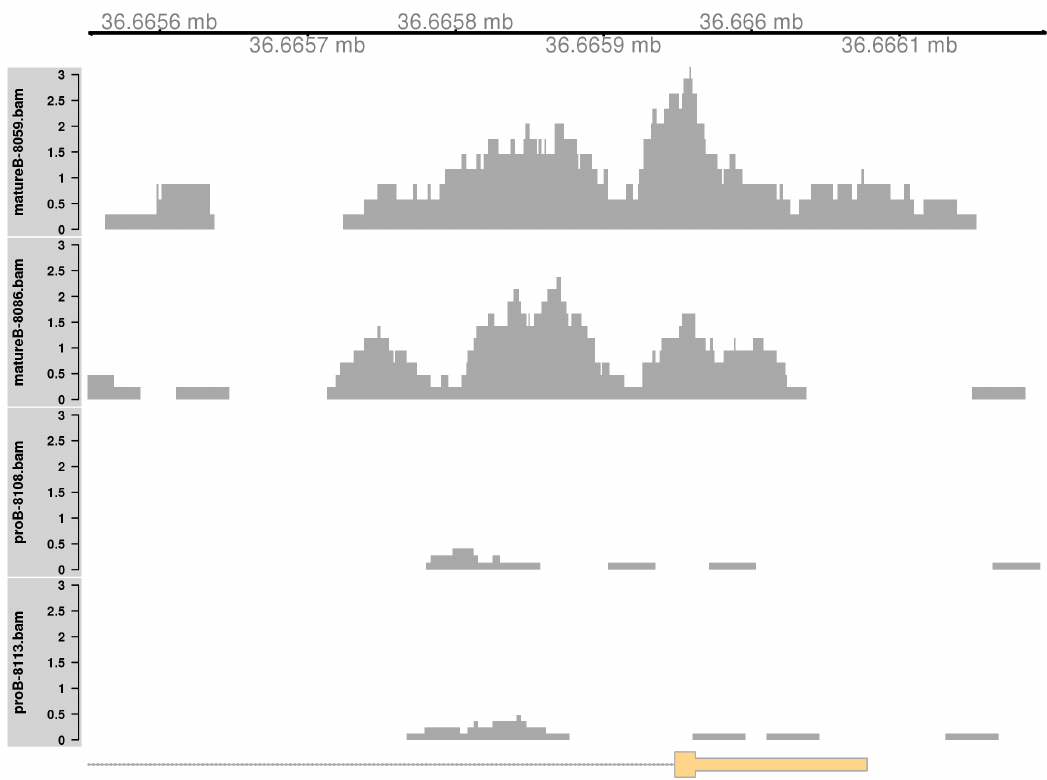
Figure 10. Coverage tracks for a sharp and simple DB event in the H3K9ac data set, shown as per-million